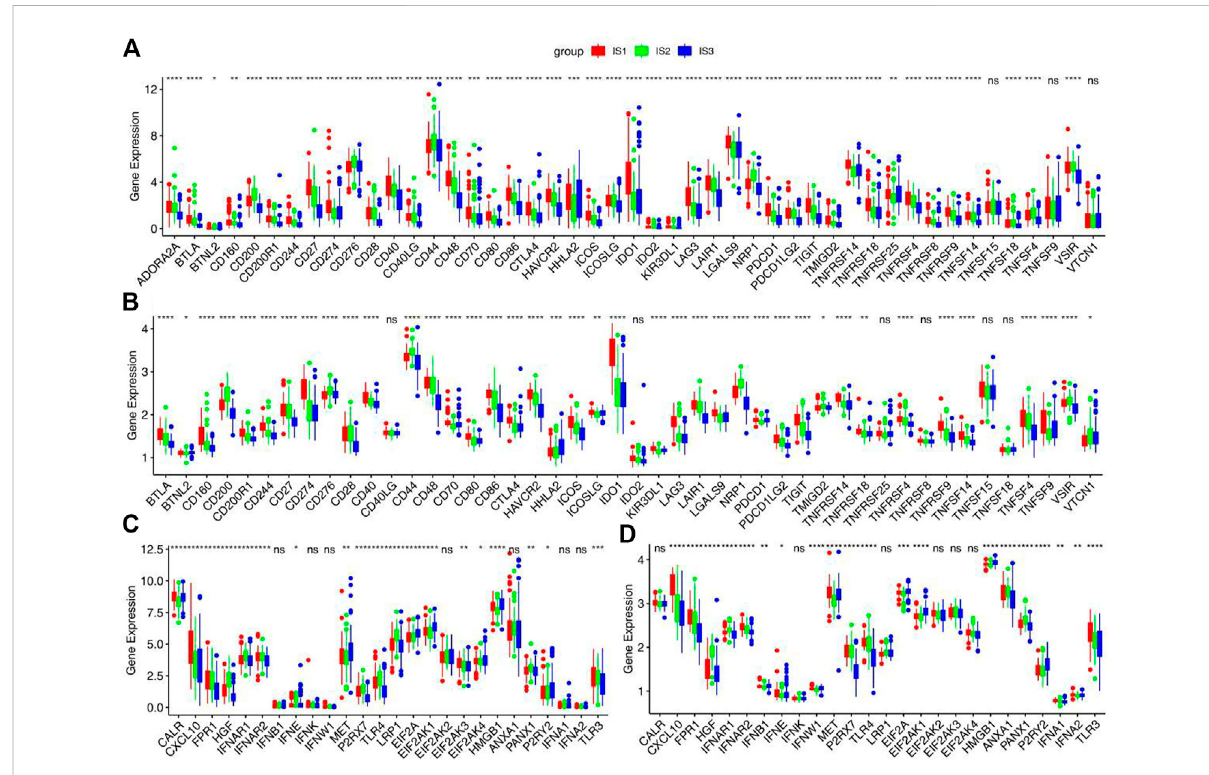
FIGURE 4 Association between immune subtypes and ICPs and ICD modulators. (A,B) Differential expression of ICPs genes among the STAD immune subtypes in (A) training cohortsand (B) GSE66229 cohorts. (C,D) Differential expression ofICD modulatorgenesamongtheSTAD